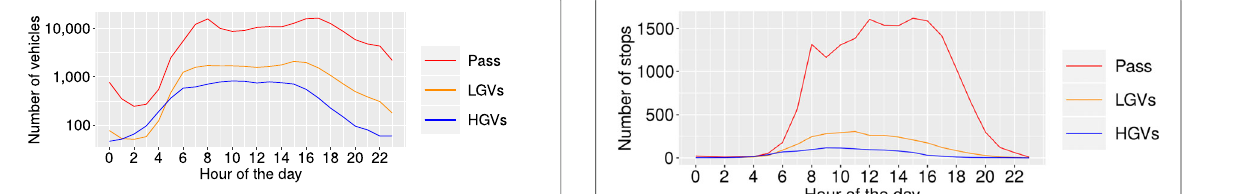
velocities of vehicles. Figure 24 shows the average velocity of different vehicle categories at various hours of the